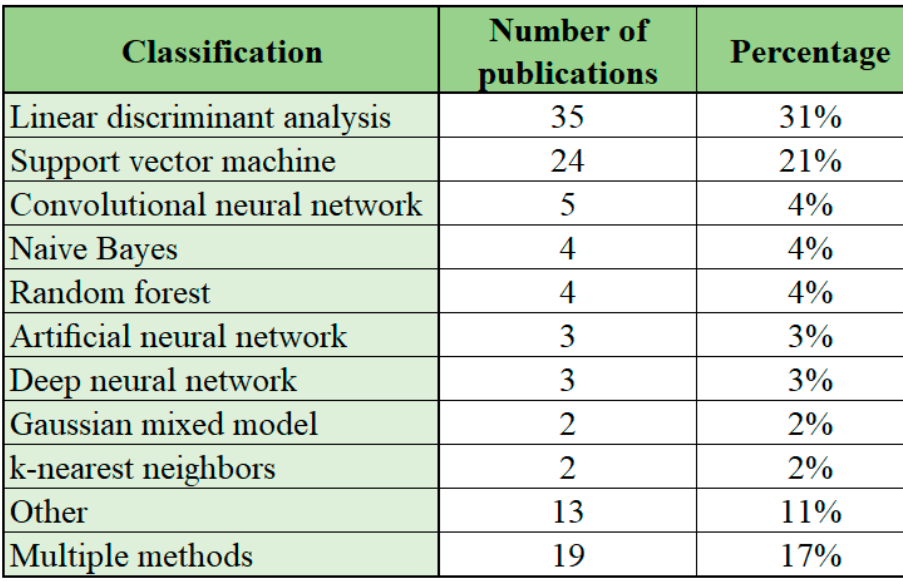
Figure 13. Classification method used in the publications ordered by the number and percentage of publications where the classification method has been used.